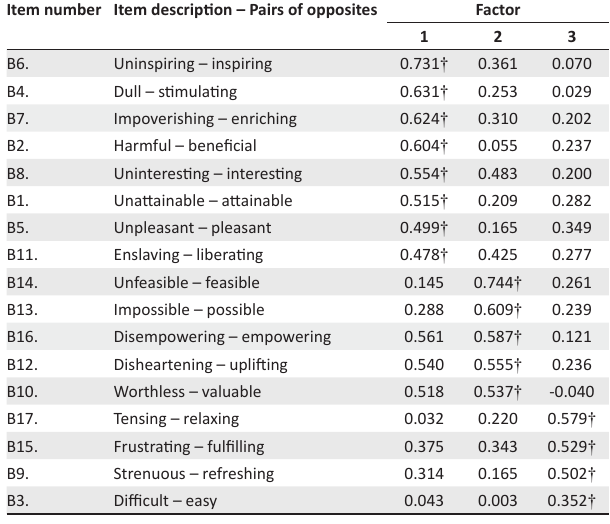
Extraction Method: Principal Axis Factoring. Rotation Method: Varimax with Kaiser Normalisation. Rotation converged in 8 iterations. † , Values of the extracted